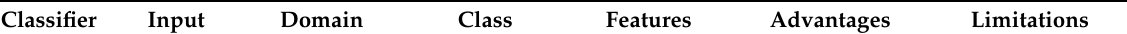
Table 1. Overview of classification methods on different urban land cover